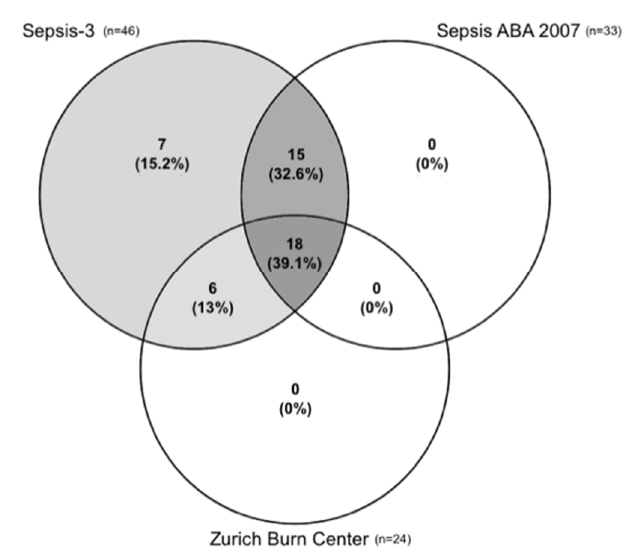
Figure 1. Venn diagram depicting the overlapping quantities of the patients meeting the criteria for the three different sepsis definitions. Sepsis was diagnosed across all definitions in 18 patients (20%). Thirty-three patients (37%) fulfilled the conditions of both Sepsis-3 and Sepsis American Burn Association (ABA) 2007. Sepsis-3 and Sepsis Zurich Burn Center had an overlap of 24 (27%) patients. Table 1. Baseline characteristics in total and according to the main outcome no infection vs. different sepsis definitions. The Kruskal–Wallis test was used for comparison of ordinal and continuous data across the three sepsis groups to rule out a potential bias by age, total body surface area (TBSA), and body mass index (BMI) (ABSI and Baux score) with regard to the subsequent longitudinal